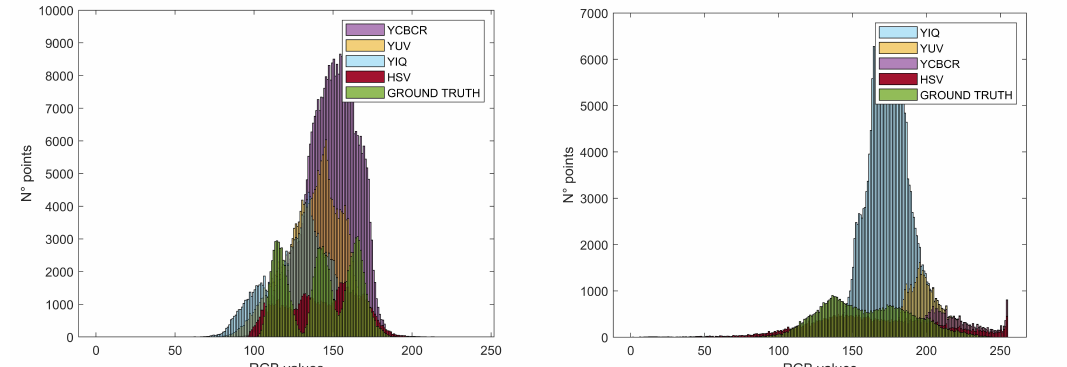
Figure 7 . Overlapping between analogous clusters histograms (unified RGB) of the four colour spaces and the ground truth. Case 2: moist area (left); staining